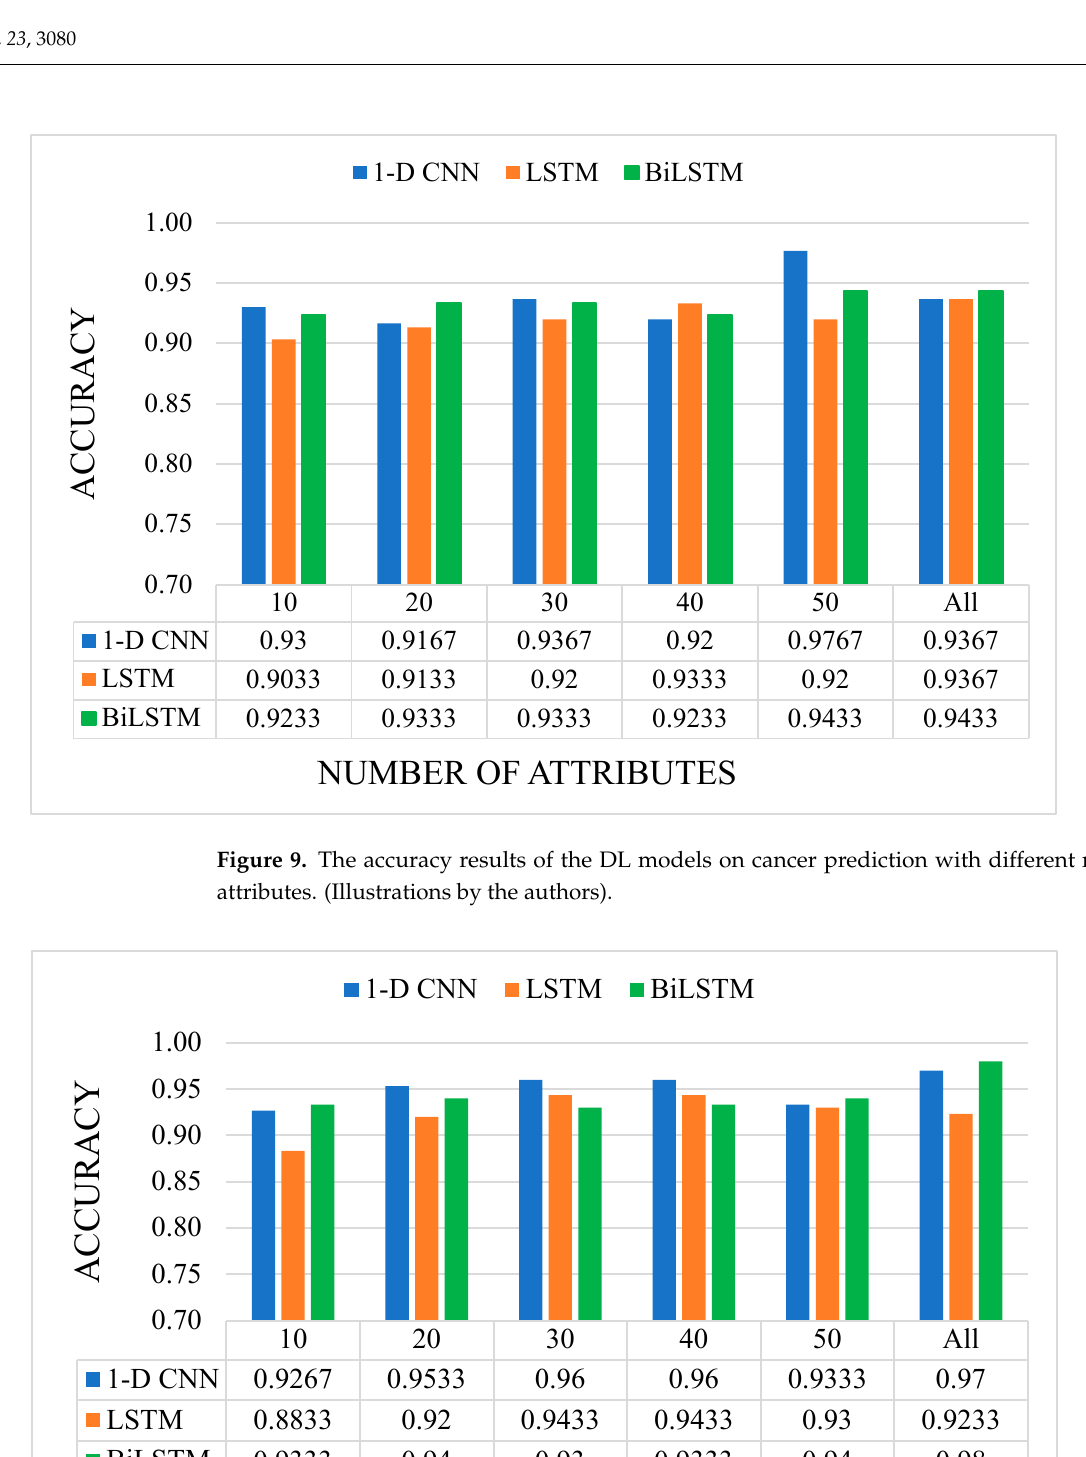
Table 10. Kappa statistics and RMSE values of algorithms on cancer prediction with all attributes. (Illustrations by the authors). Method